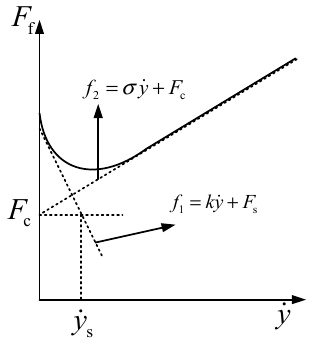
Figure 12. Stribeck friction model graph.